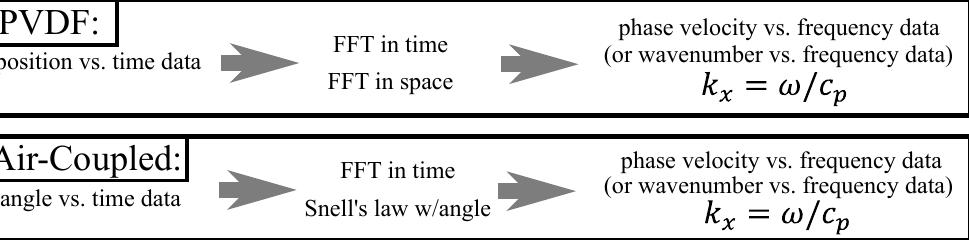
Figure 7. Flow chart of the methods used to calculate the wavenumber–frequency spectra of the PVDF and air-coupled transducer